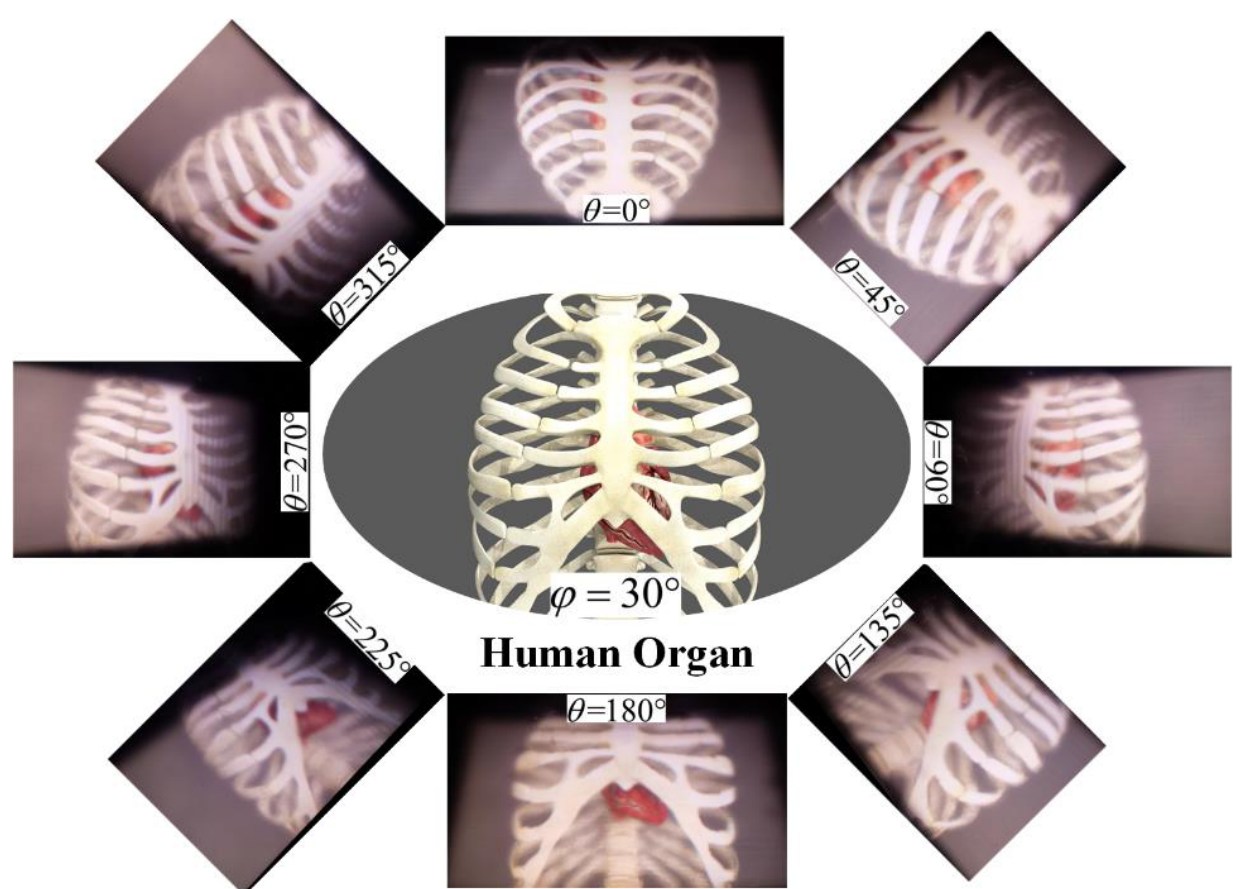
Figure 8. Different perspectives along the annular direction of the 3D human organ of heart and sternum (Video S2).